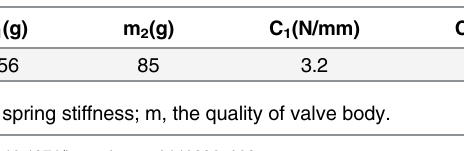
Table 2. Experimental valve quality and spring stiffness.